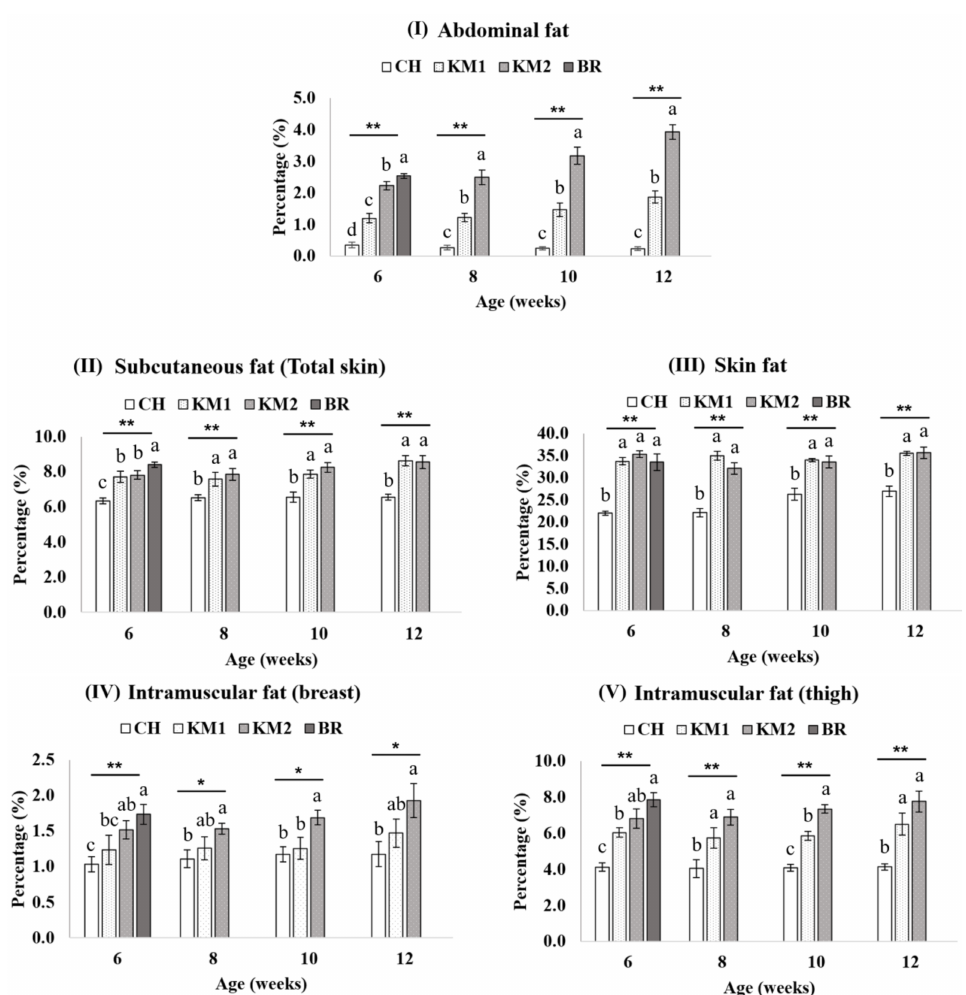
Figure 1. The fat deposition traits including abdominal fat ( I ), subcutaneous fat ( II ), skin fat ( III ), breast intramuscular fat ( IV ), and thigh intramuscular fat ( V ) comparison between breeds of chicken in 6–12 weeks of slaughtering age. CH = Chee, KM1 = Kaimook e-san1, KM2 = Kaimook e-san2, BR = Broiler chicken. a, b, c and d Mean values within a figure with no common letter differ significantly (* mean p < 0.05 and ** mean p <